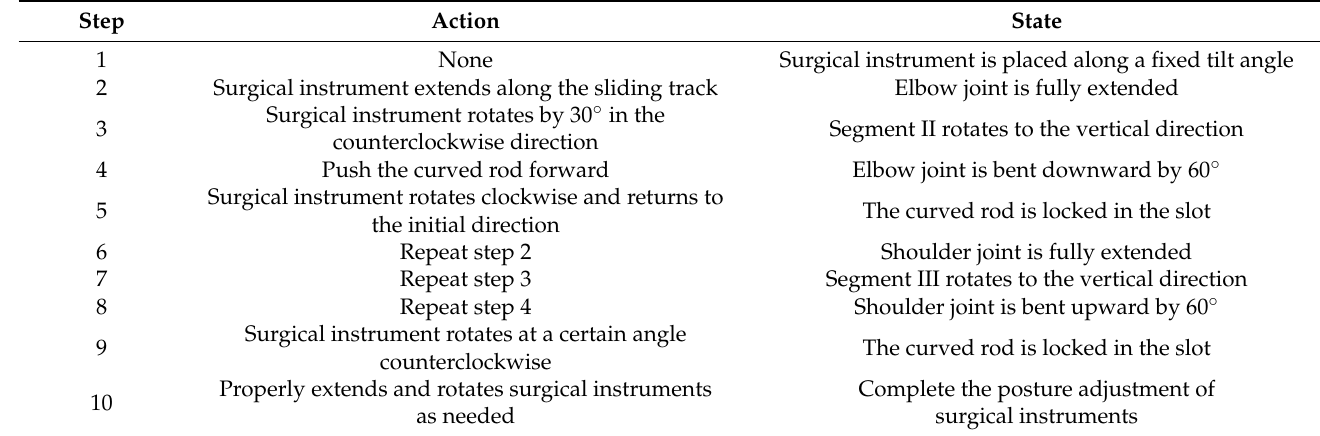
Table 1. The unfolding process of the articulated arm.